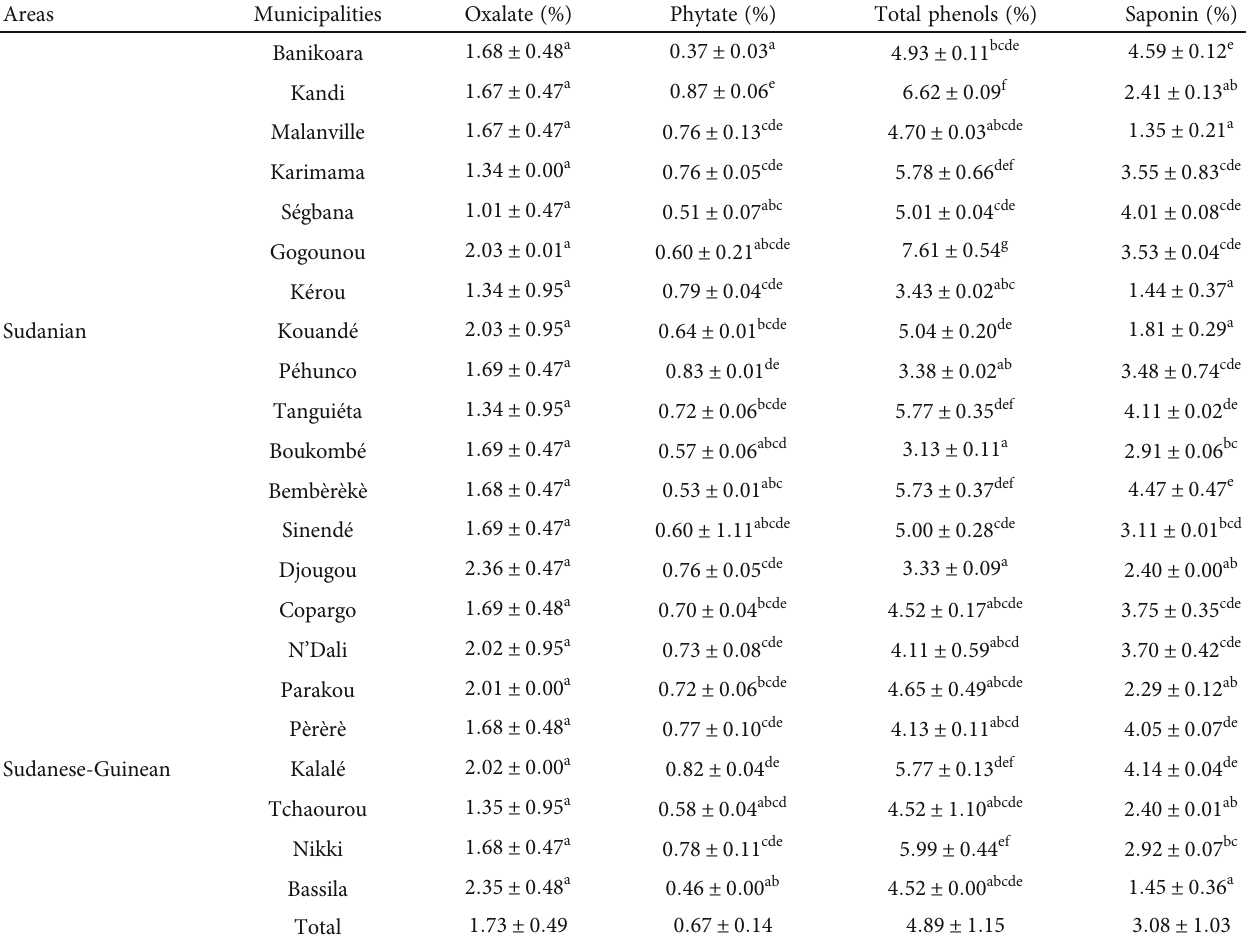
Table 4: Antinutritional factors of Detarium microcarpum